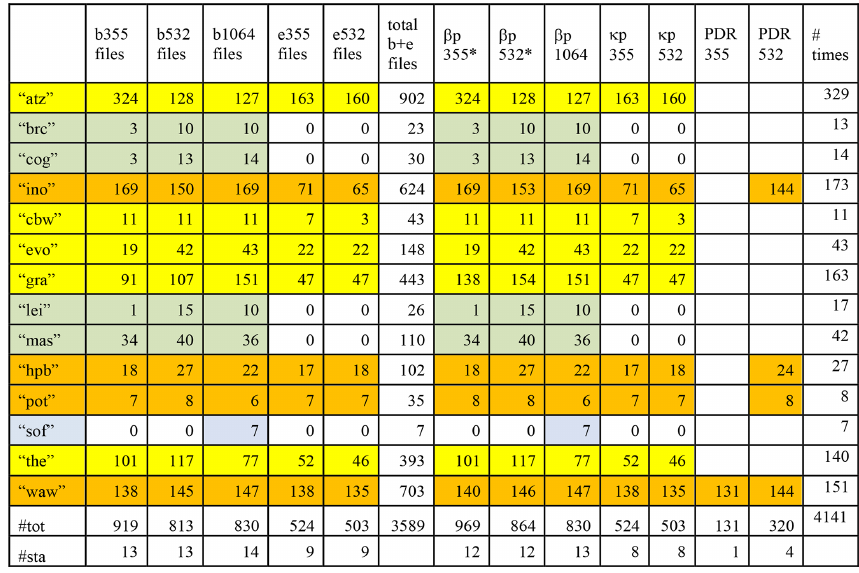
stamps with at least one profile of optical properties (the total number being